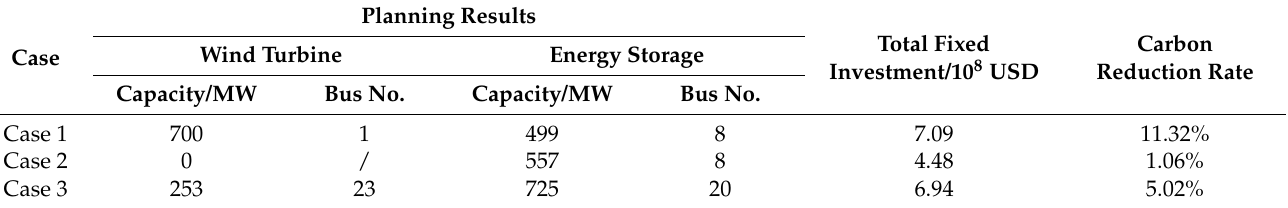
Table 7. Planning results of different cases in Scenario